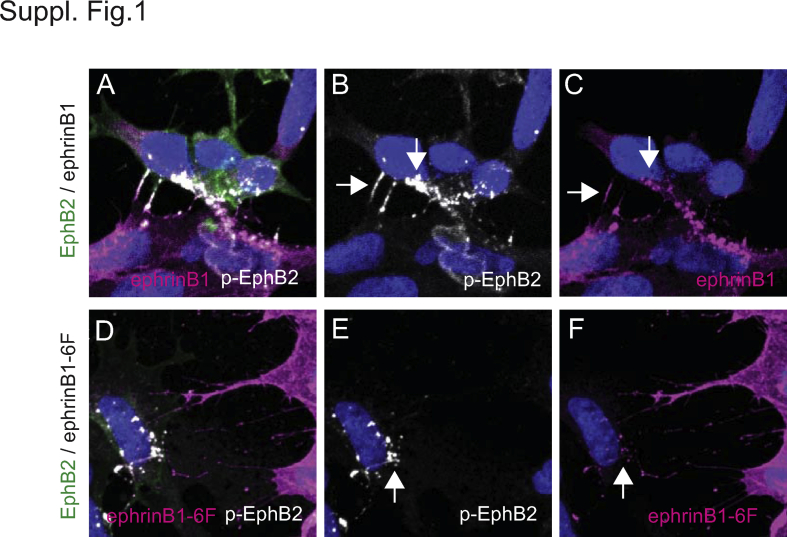
Relationship between activated EphB2 and wild type or mutant ephrinB1. (A-F): Immunostaining of cell cultures to detect ephrinB1 and p-EphB2. In (A and D), the green signal is GFP which marks EphB2 cells. Both in EphB2/ephrinB1 (A-C) and EphB2/ephrinB1-6F (D-F) cultures, p-EphB2 and ephrinB1 are detected in retraction fibres and in vesicles (arrows). There is overlap between signal for p-EphB2 and ephrinB1, reflecting that after binding they are endocytosed as an intact complex.